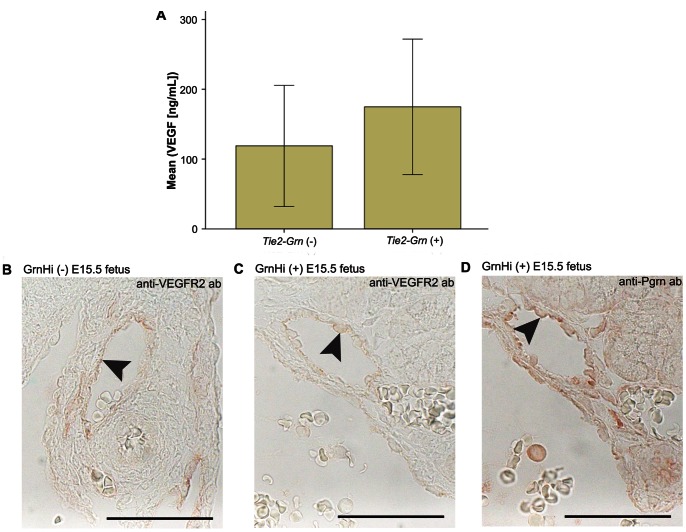
Relationship between Tie2-Grn expression and VEGF-A/VEGFR2 expression.(A) VEGF-A protein levels in the amniotic fluid. Independent samples T-test revealed no significant difference in VEGF-A levels between the Tie2-Grn positive fetuses and the Tie2-Grn negative fetuses (p = 0.423). Age of fetuses are E15.5–16.5. N = 8, GrnHi line. Error bars denote +/− S.E. VEGFR2 endothelial expression in (B) Tie2-Grn negative fetus and (C) Tie2-Grn positive fetus. Arrows show endothelial cells within the mesenteric vessels. (D) Serial sections of the Tie2-Grn vessel in (B) expressed progranulin. Scale bars denote 20 µm. Images were obtained from the GrnHi line.